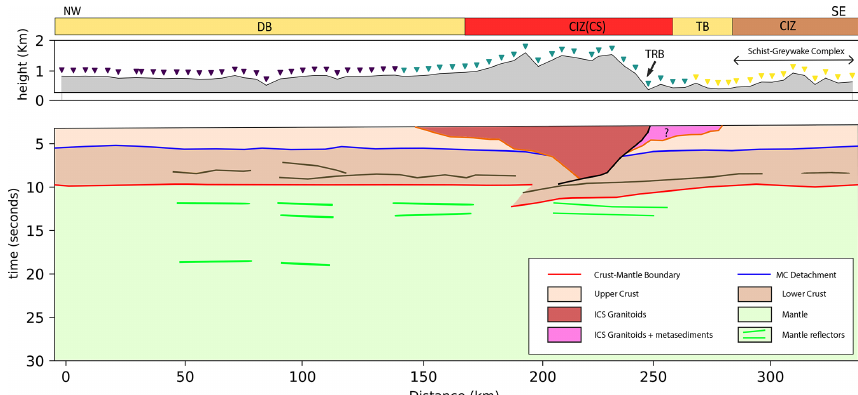
Figure 5. Sketch of the proposed crustal structure below the Iberian Central System and the Duero and Tajo basins. Black solid line defines the ICS southern thrust. A crustal-scale thrust can be defined to the south of the ICS. In its upper part it may coincide with the Tietar River fault (TRF). It then follows the southern boundary of the ICS and reaches the lower crust, offsetting it to define a crustal